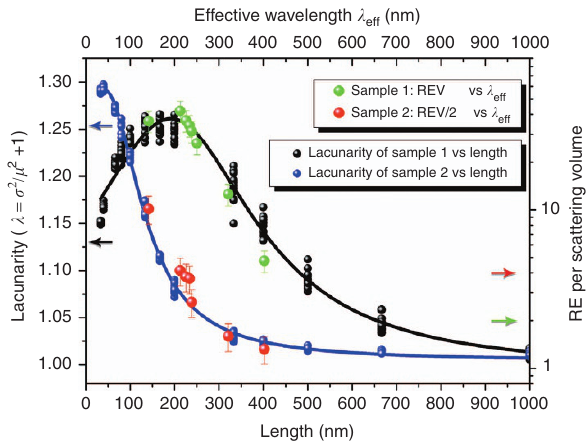
Figure 5 Comparison between lacunarity and Raman enhancement. The Raman enhancement of sample 1 (green dots) and sample 2 (red dots) plotted as a function of the effective incident laser wavelength propagating in the medium λ eff and compared with the corresponding lacunarity curves (black and blue lines represent samples 1 and 2,